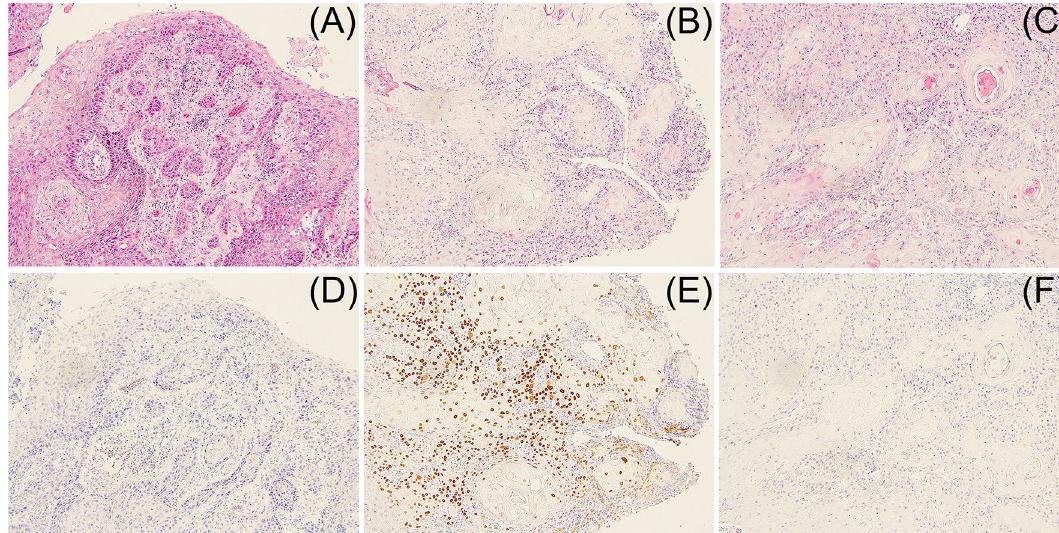
Figure 2. Immunohistological evaluation of p53 in oral squamous cell carcinoma (OSCC) cases. No abnormal accumulation of p53 protein in the nucleus was observed in cases in which no mutation was found by next- generation sequencing (NGS) ( A , D ). In cases with a mutation detected by NGS, abnormal nuclear accumulation of p53 protein was found immunohistologically ( B , E ). In cases with a truncation mutation detected by NGS, the absence of abnormal nuclear accumulation of p53 protein was shown immunohistologically ( C , F ).